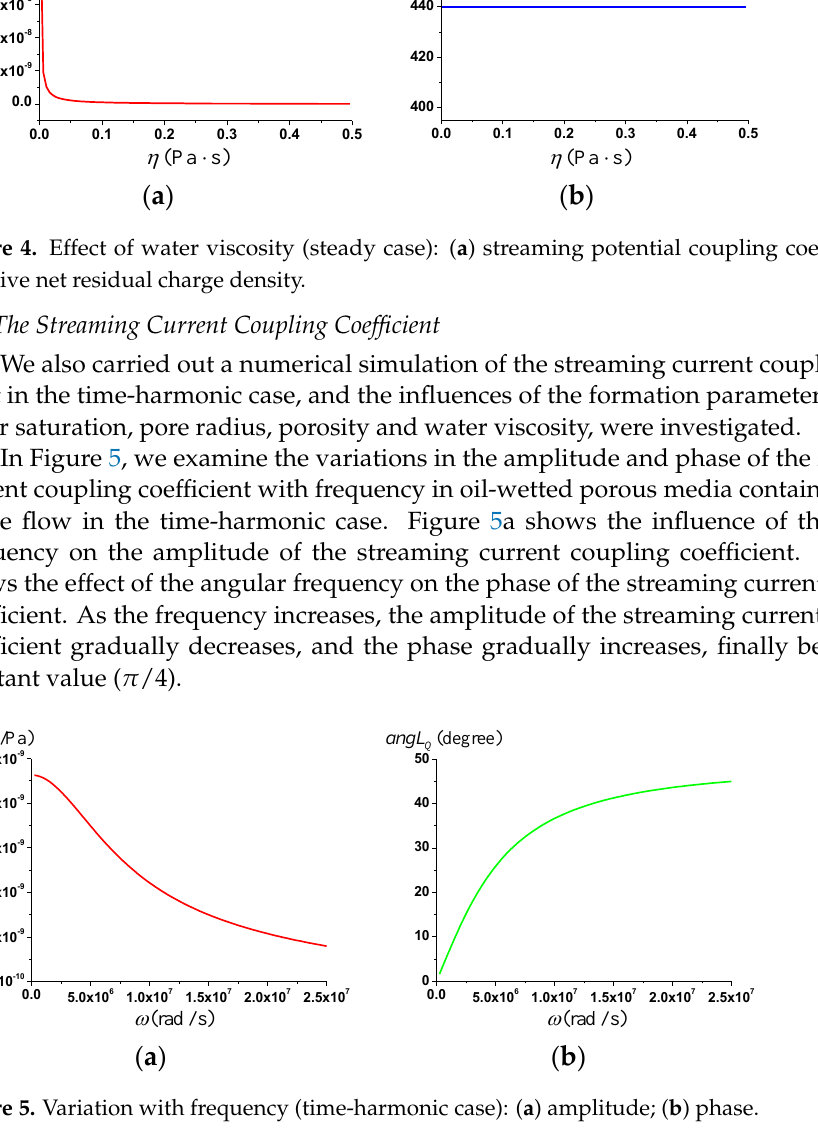
( b ) Figure 6. Effect of water saturation (time-harmonic case): ( a ) streaming current coupling coefficient; ( b ) effective net residual charge density. Comparing Figure 1 and Figure 6, with a decrease in the water saturation, the cou- pling coefficient of the streaming potential first increases and then decreases, and there is a peak point: 0.35 w s =